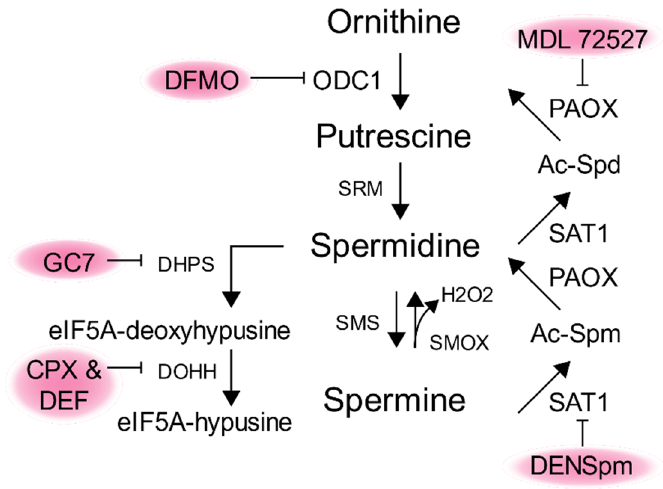
Figure 6. Polyamine-modulating molecules with antiviral activity. Several molecules target polyamine biosynthesis to alter polyamine levels and hypusinated eIF5A within the cell. Difluoromethylornithine (DFMO), MDL 72527, diethylnorspermidine (DENSpm), N 1 -guanyl-1,7-diamineheptane (GC7), ciclopirox (CPX), and deferiprone (DEF) target distinct metabolic enzymes and exhibit antiviral activity.